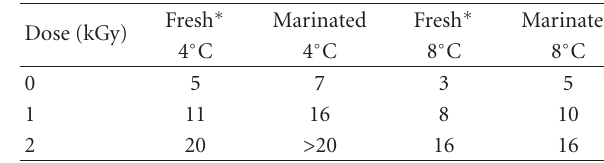
Table 2: Shelf-lives at 4 and 8 ◦ C of fresh and marinated pork loin subjected to E-beam